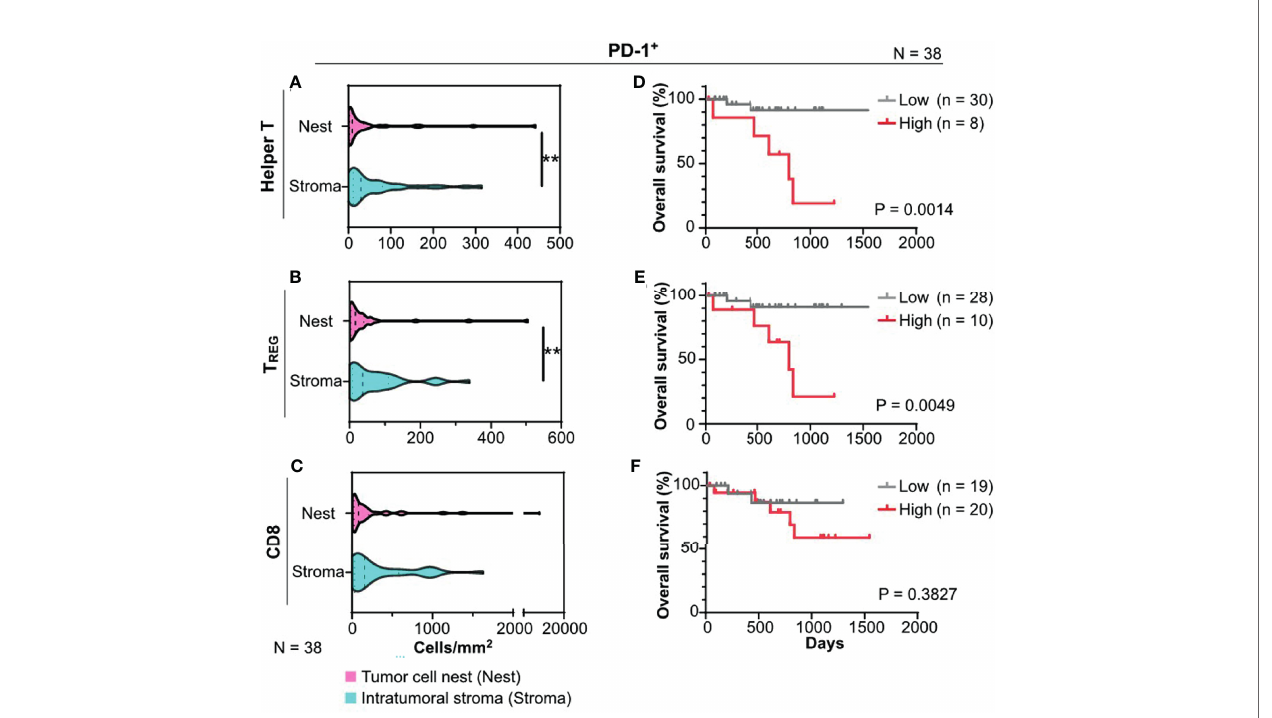
FIGURE 3 | PD-1 + T cells in fi ltrated in tumor cell nests are associated with prognosis of HNSCC. (A – C) PD-1 + cell densities of helper T cells (A) , regulatory T cells (T REG ) (B) , and CD8 + T cells (CD8) (C) were shown, comparing the intratumoral stroma and tumor cell nests. Statistical differences were determined via Wilcoxon signed rank tests, with **p < 0.01. (D – F) Kaplan – Meier analyses of overall survival strati fi ed by cell densities of PD-1 + cell densities of helper T cells (D) , TREG (E) , and CD8 (F) were shown (cutoff = mean). Statistical signi fi cance was determined using the log-rank